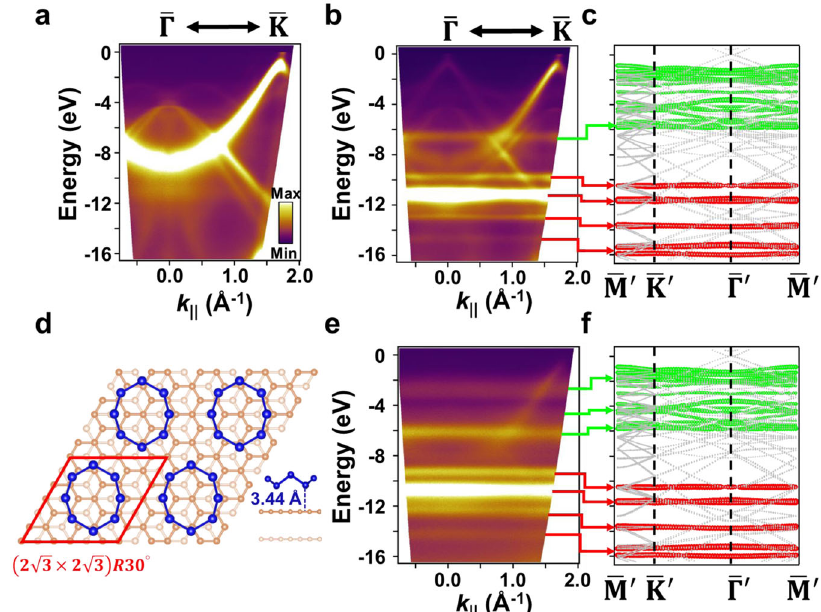
Fig. 2 Nondispersive bands from molecular Se 8 and structural model. a ARPES map along Γ K from a clean BLG at 30 K. b Similar ARPES map of Se-covered BLG maintained at 20 K. c Theoretical band structure for a 2 curves indicate bands derived from Se p - and s -orbitals, respectively. d Adsorption geometry for Se 8 on BLG from calculations. e ARPES map from a Se-saturated surface at 20 K further deposited with 10 Å of Se. f Same calculation as c for a side-by-side comparison with e